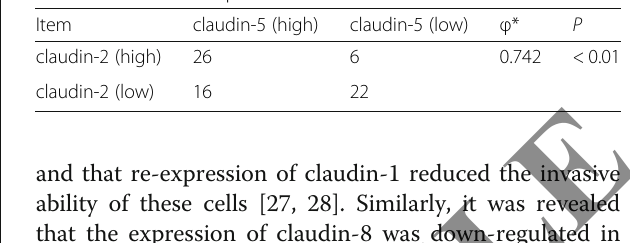
Table 4 Correlation between the expression of claudin-2 and claudin-5 in non-neoplastic mucosae